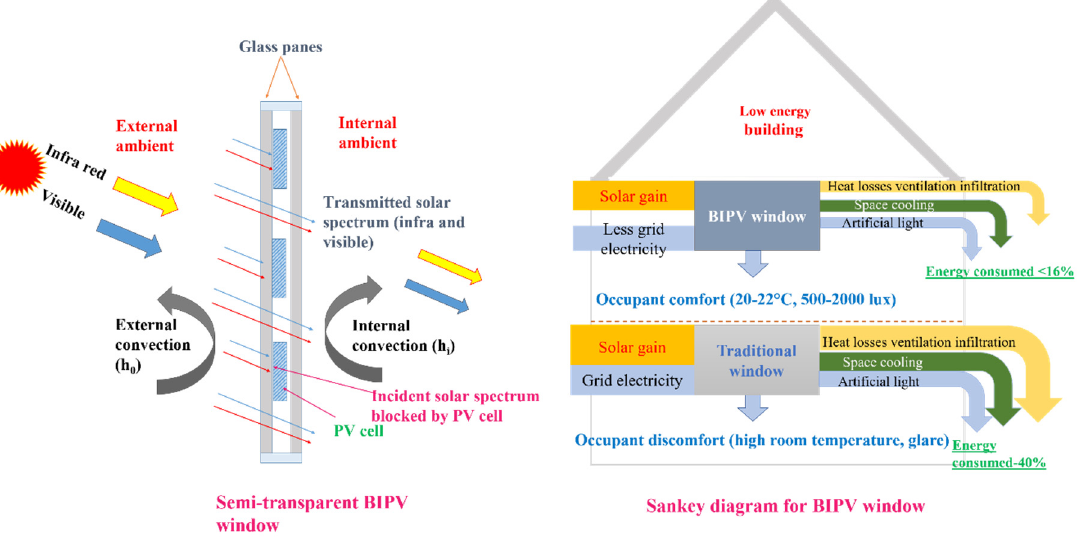
Figure 9. Schematic of a semitransparent BIPV window (left) and Sankey diagram while BIPV window is integrated into a building (right).